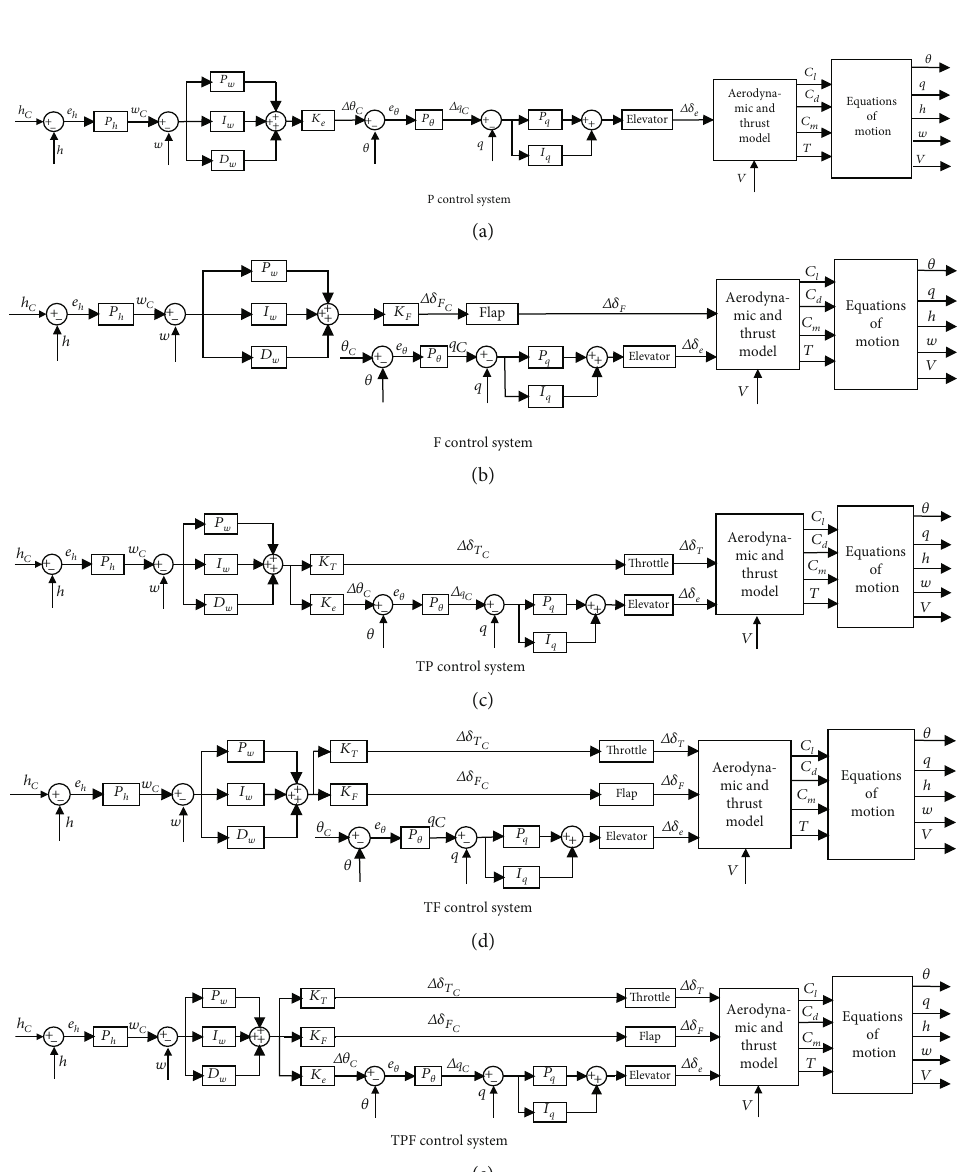
Figure 3: Structures of di ff erent height control systems. (a) P control system. (b) F control system. (c) TP control system. (d) TF control system. (e) TPF control